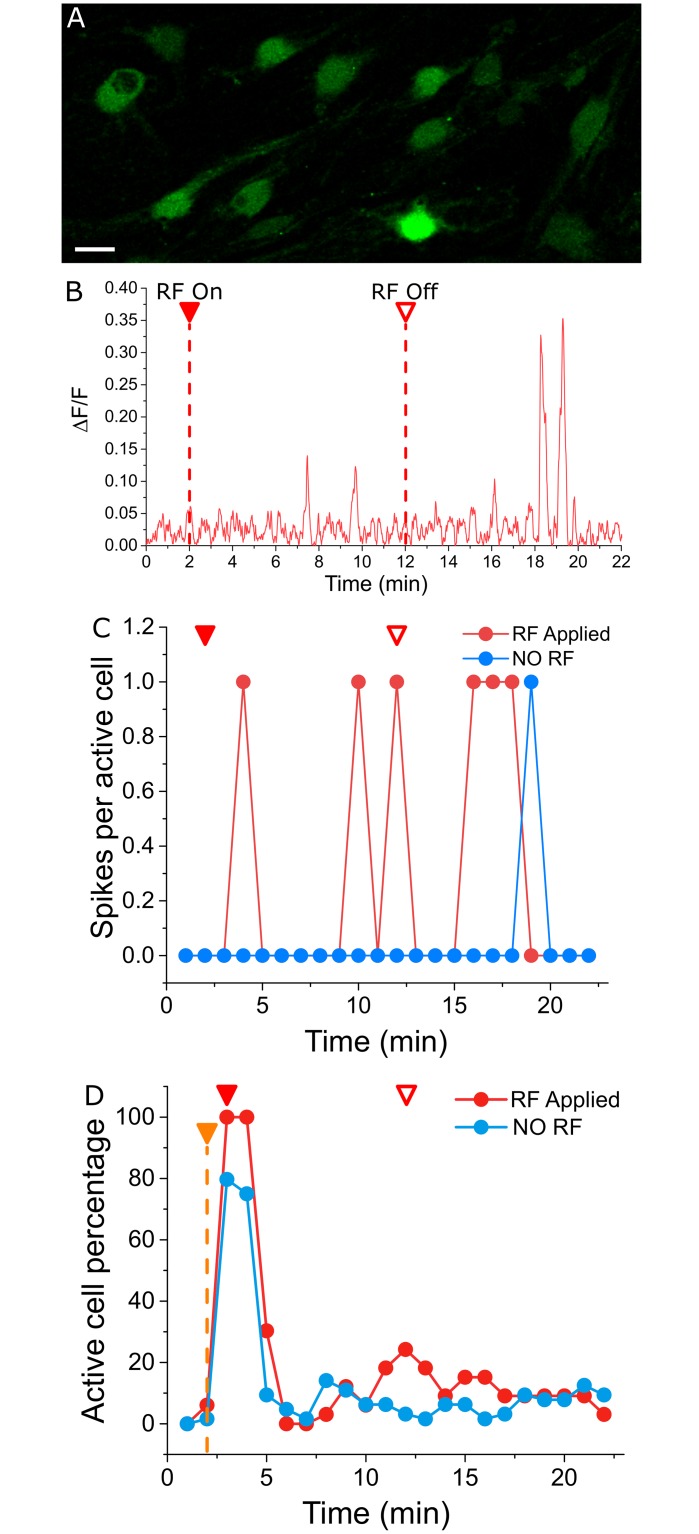
Effects of RF EMF on the spontaneous spiking activity of dissociated DRG sensory neurons in the absence and presence of inflammatory cytokine, TNF-α.(A) Representative confocal image of dissociated DRG neurons following 15 min incubation with 5 μM Fluo-3 AM (Scale bar = 15 μm). (B) Unsmoothed ΔF/F for a single cell. Spikes correlate to an increase in intracellular calcium concentration. (C) Spikes per active cell calculated at 0.35 for RF EMF ‘OFF’ (n = 163) or ‘ON’ (n = 232). Spikes persisted after removal of the RF stimulus, which was consistent with observations from behavioral assays. (D) A larger percentage of DRG neurons were active when RF EMF stimulus was applied to cultures perfused with inflammatory cytokine TNF-α (10 ng/ml).